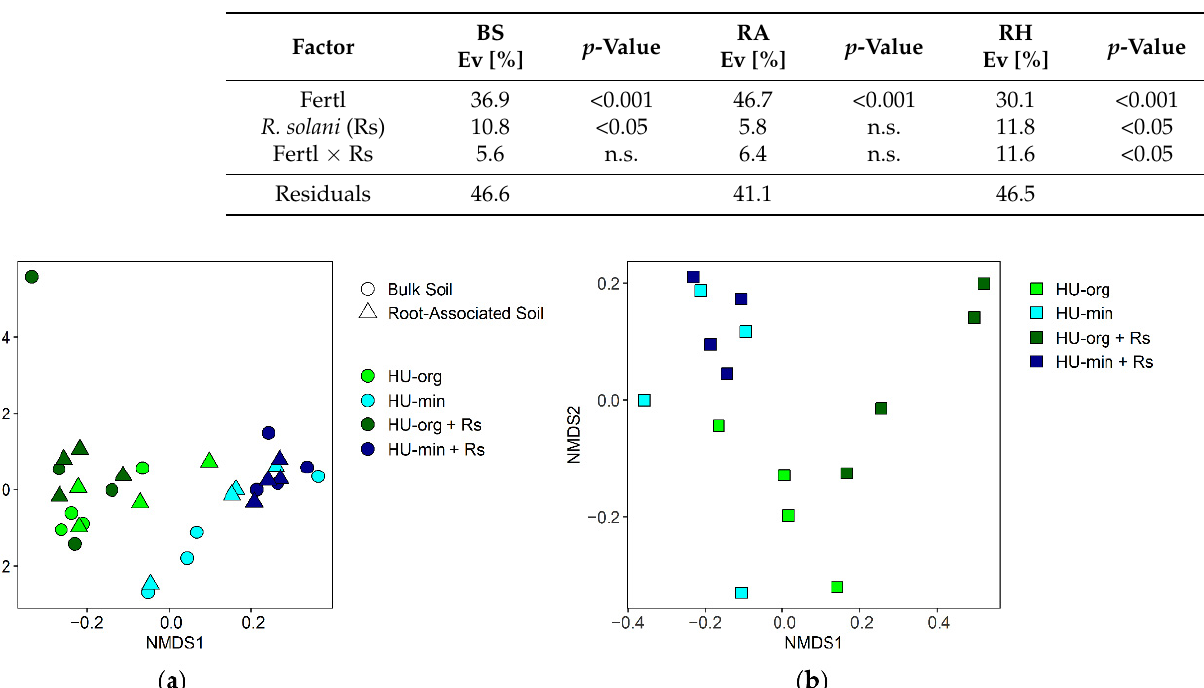
Table 4. Effects of long-term mineral and organic fertilization strategy (Fertl) and the presence of the pathogen Rhizoctonia solani AG1-IB on fungal community composition in bulk soil (BS), root- associated soil (RA) and the rhizosphere (RH) of lettuce (cv. Tizian). PERMANOVA analysis based on Bray–Curtis distances (10,000 permutations). Ev—explained variance.